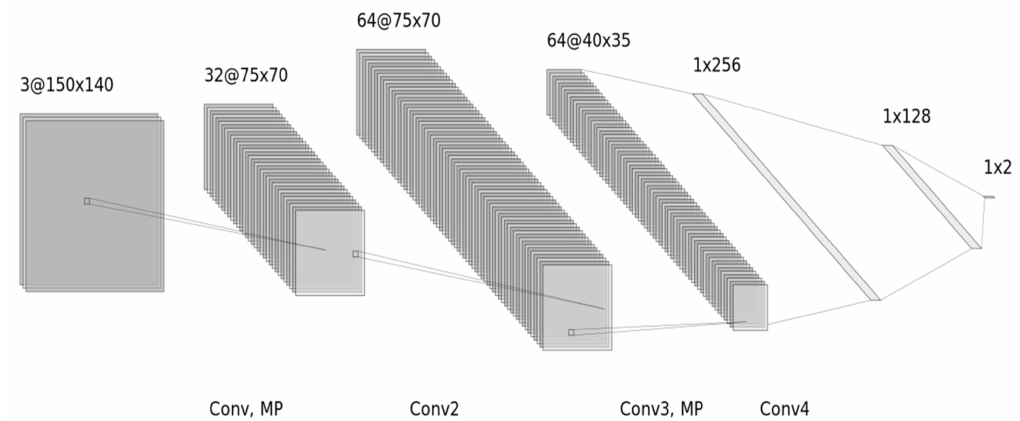
Figure 6. Bespoke convolutional neural network